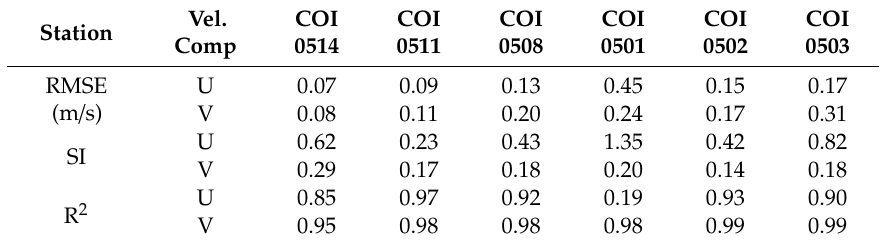
Table 2. Error statistics (RMSE, SI, and R 2 ) for depth-averaged tidal currents at six ADCP survey stations inside Cook Inlet (The top row is for the east velocity (U) component and the bottom row is for the north velocity (V) component).